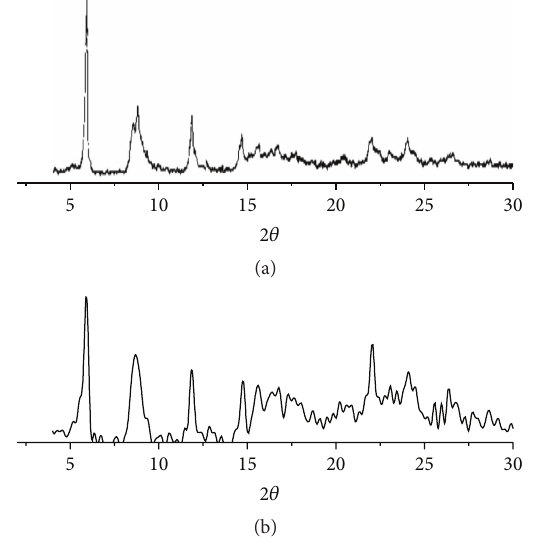
Figure 5: X-ray powder diffraction patterns of (a) Cu 2 Indo 4 (H 2 O) 2 reported in [21] and (b) the precipitate in the stoichiometry 2: 4 (Cu 2 Indo 4